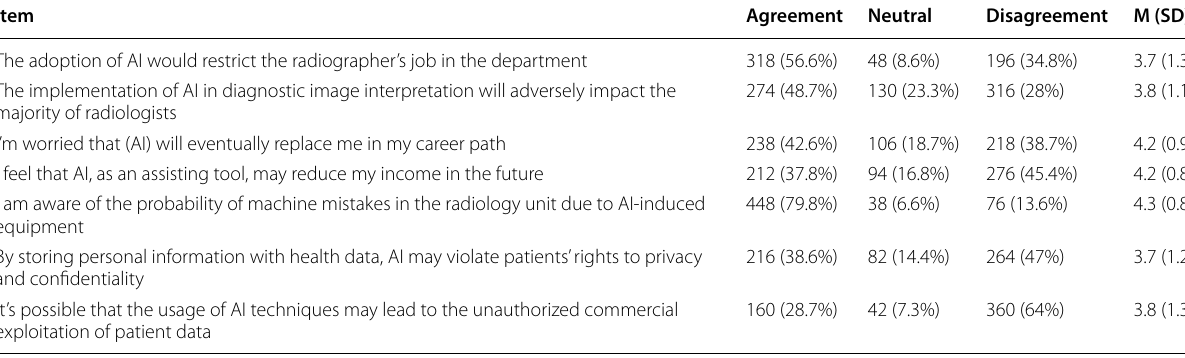
Table 4 Respondents’ thoughts on the potential negative effects of AI in diagnostic imaging